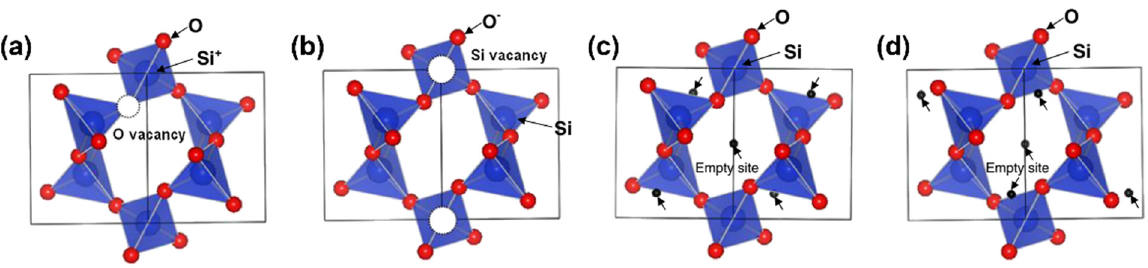
Figure 3. The crystalline structure of SiO 2 ( P 3121 space group) drawn via the VESTA method ( a ) with O vacancy, ( b ) with Si vacancy, and ( c , d ) with empty sites. Reproduced with permission from ref. [1]. Copyright 2011, The Ceramic Society of Japan.